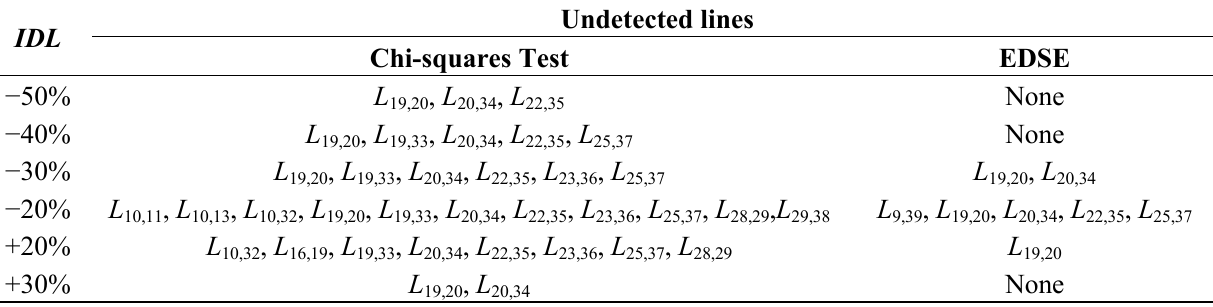
Table 8. Undetected lines of traditional test and extended distributed state estimation (EDSE)-based method. Undetected